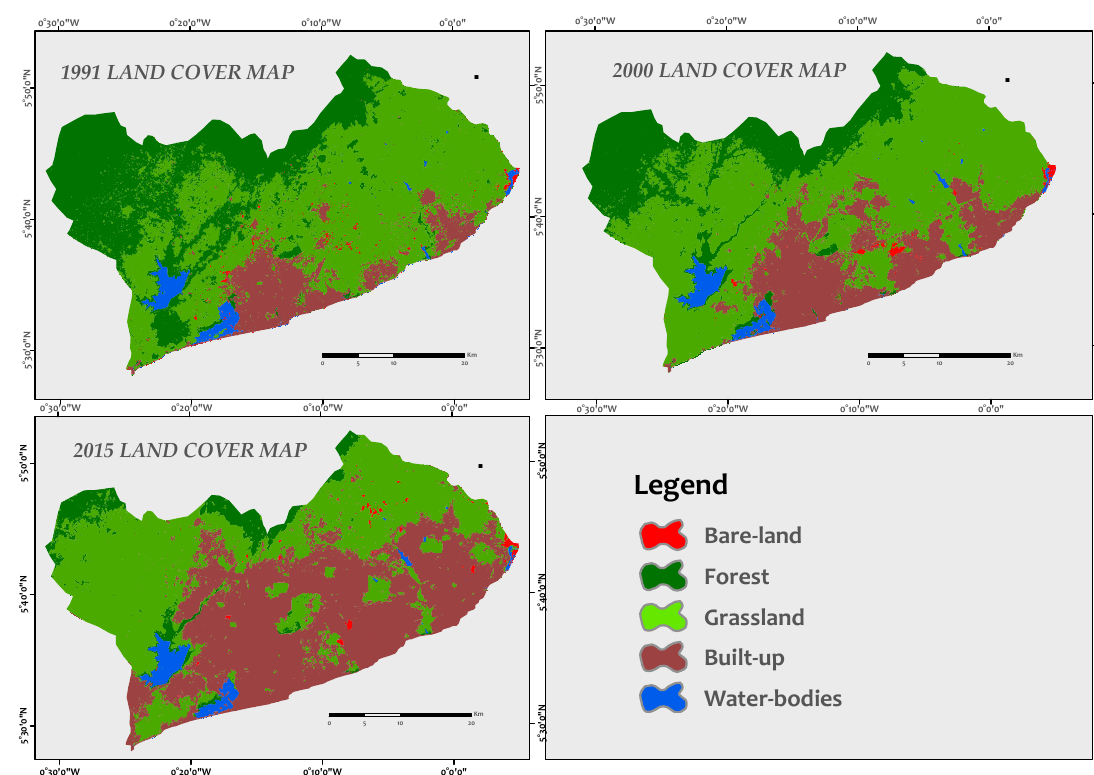
Figure 6. 1991, 2000, and 2015 land use/land cover maps of GAMA.